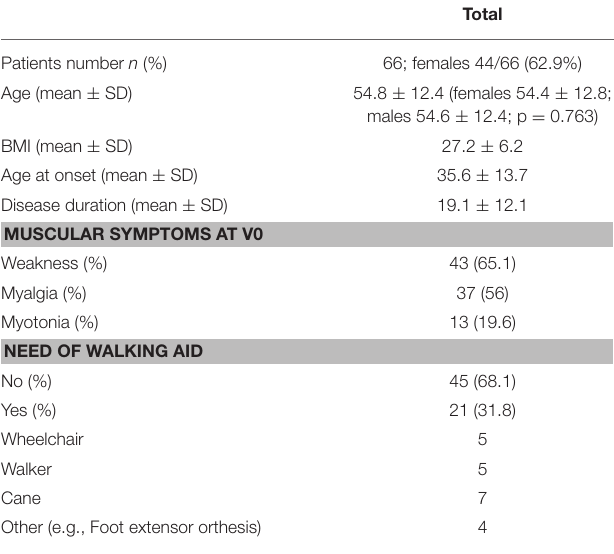
TABLE 1 | Demographics and baseline characteristics of DM2 patients.